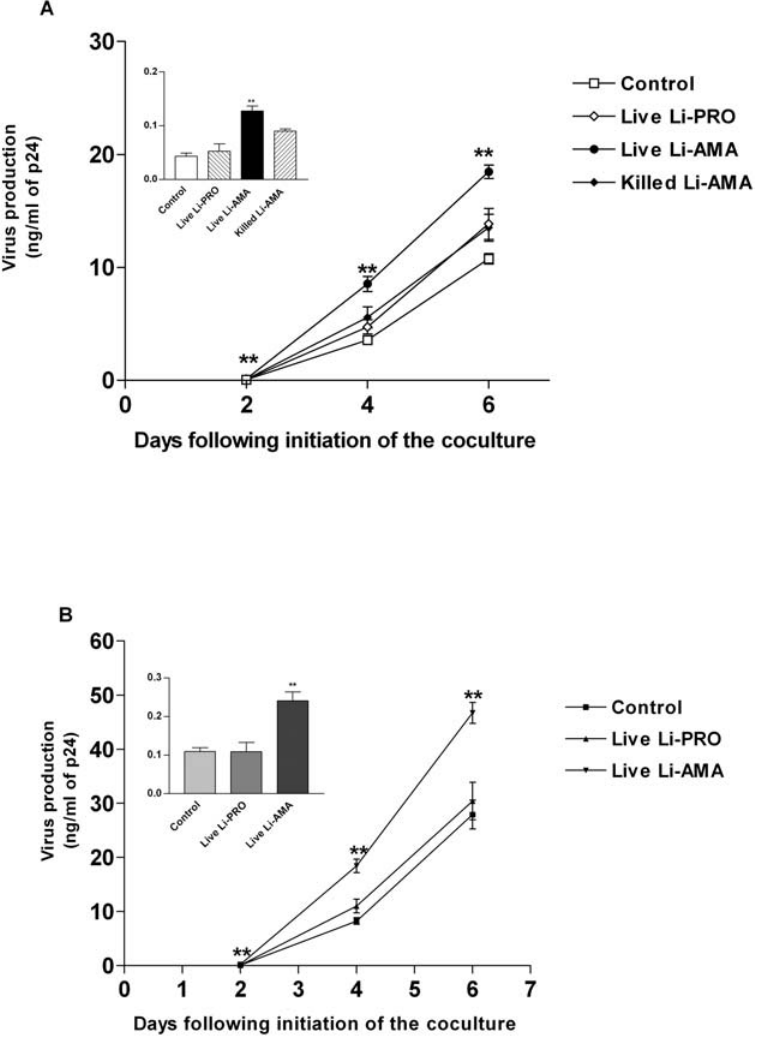
Figure 1. Leishmaniainfantum amastigotes enhance HIV-1 replication in cocultures consisting of DCs and autologous CD4 + T cells. First, iDCs (A) and mDCs (B) were pulsed for 60 min with NL4-3Bal env and either left unexposed (Control) or exposed to live Leishmania infantum promastigotes (Live Li-PRO), live Leishmania infantum amastigotes (Live Li-AMA), or killed Leishmania infantum amastigotes (Killed Li-AMA). Next, cells were cocultured with autologous CD4 + T cells and virus production was estimated by measuring p24 levels in the culture supernatants at the indicated time points. Virus production at day 2 following initiation of the coculture is depicted in the small inserts (upper left part of each panel). Data shown represent the means 6 SEM of triplicate samples and are representative of six independent experiments. Asterisks denote statistically significant differences from the cells infected with HIV-1 only (**, P , 0.01).